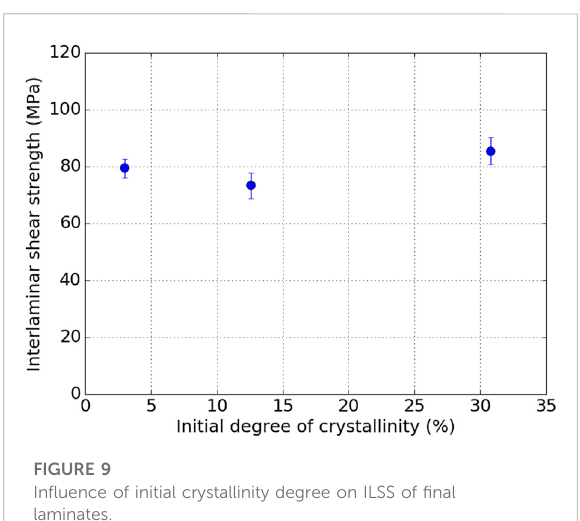
FIGURE 9 In fl uence of initial crystallinity degree on ILSS of fi nal